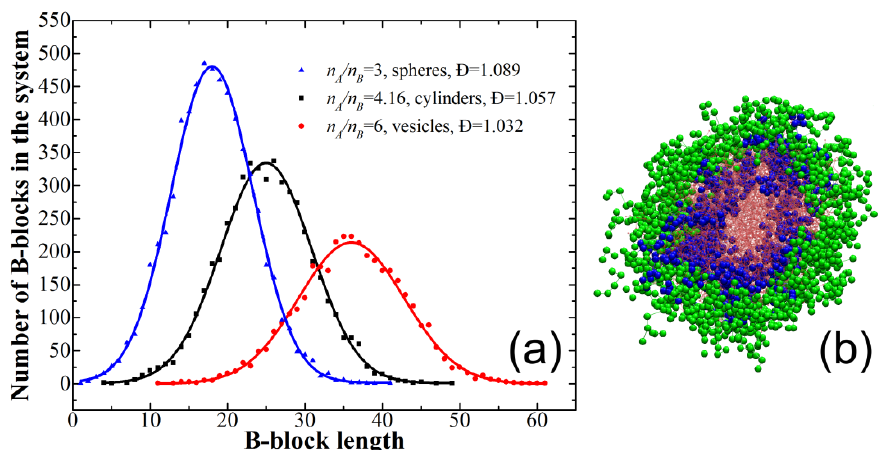
Figure 4. ( a ) Typical solvophobic block-length distributions observed in PISA for φ = 0.1; ( b ) cross- section of the cylindrical micelle obtained during PISA at n B / n A = 5.5 (i.e., with average n B = 33) and φ = 0.1. The solvophilic block is shown in green, B-blocks of length < 27 are shown in blue, and all other B-block (i.e., with a length ≥ 27) are shown in red and are